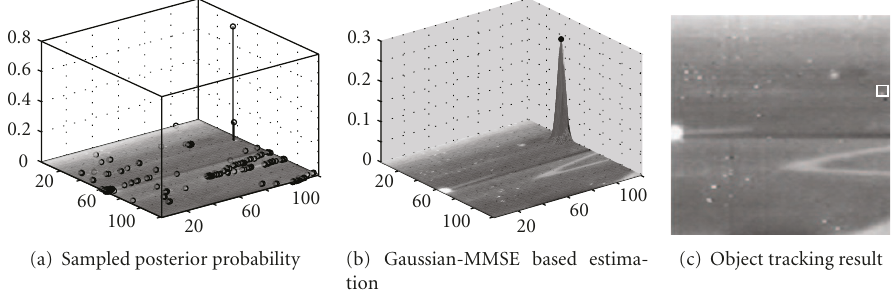
Figure 13: Tracking results for the DEH algorithm in a situation of strong ego-motion.